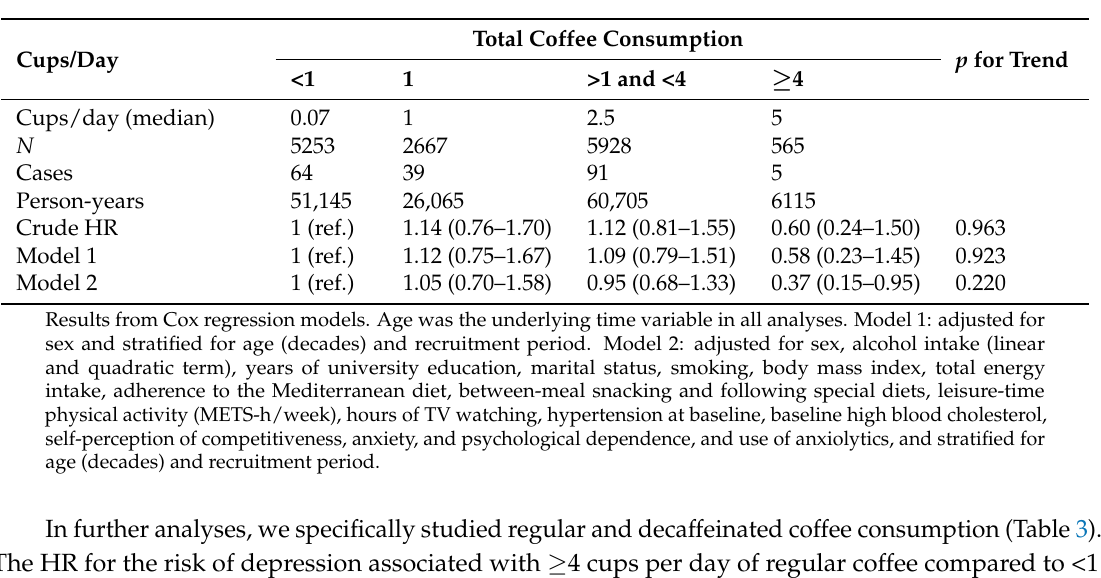
Table 2. Hazard ratios (HR; 95% confidence intervals) for incidence of depression according to baseline total coffee consumption.